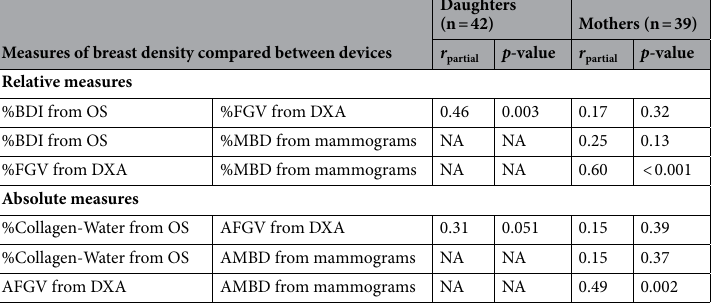
Table 2. Partial correlation coefficients comparing breast density measures from different devices, adjusting for age and body mass index, in daughters and mothers from the Growth and Obesity Study in Santiago,